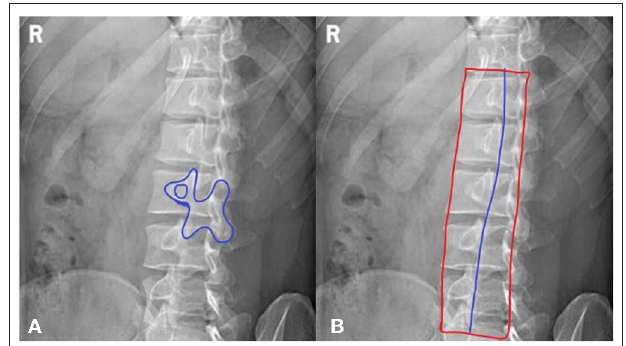
FIGURE 1 | A method for jugement of “Dog” sign. (A) The dog’s mouth is for ipsilateral transverse process. The dog’s eye is for pedicle. The dog’s ear is for superior articular process. The dog’s neck is for interarticularis. The dog’s body is for lamina. The dog’s front leg is for inferior articular process. The dog’s tail is for contralateral transverse process. (B) The inferior articular processes were connected in blue line.